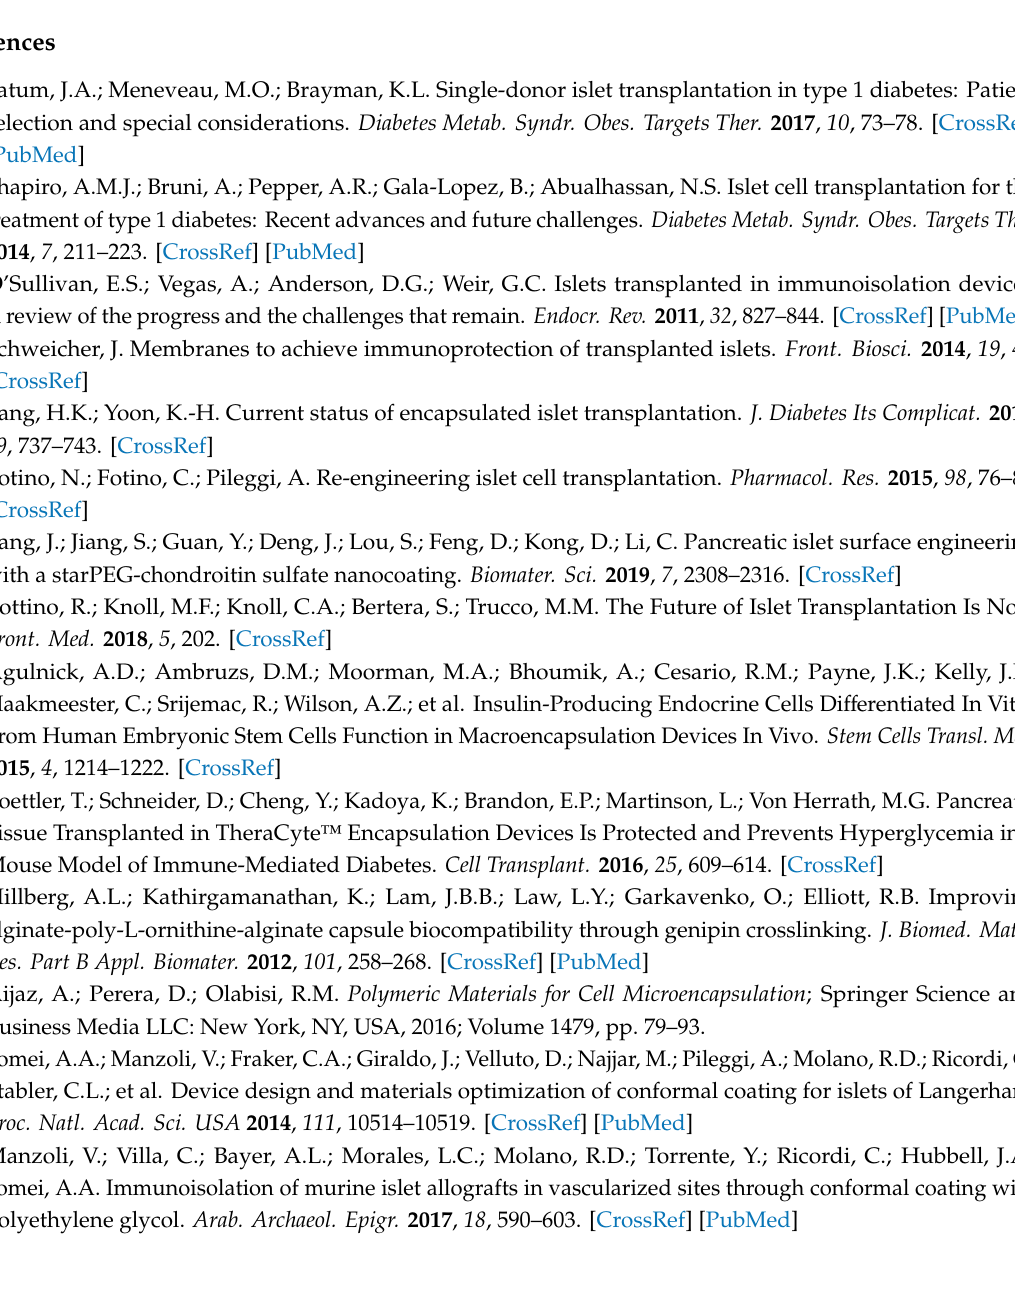
Figure S1: Values of contact angle of either gold surface, gold surface after 12 h and 60 h incubation with MUA, or gold surface after 60 h incubation with MUA and NTA. Reported values have been averaged over 5 measurements. Error bars represent standard deviation (SD). (*** p < 0.001, ** p < 0.01). Figure S2: Schematic representation of the experimental design for the conformal encapsulation of islets through photopolymerization. Islets are incubated with the photoinitiator that adsorbs on the islet surface. The islet-photoinitiator complex is incubated with the PEGDA and exposed to UV to encapsulate the islet, inducing the crosslinking of the polymer. Author Contributions: Conceptualization, L.B., A.Q., and M.M.; methodology, A.C., U.M., A.B., and T.V.; writing and editing, A.C., U.M., L.B., and A.Q.; supervision, A.S. All authors have read and agreed to the published version of the